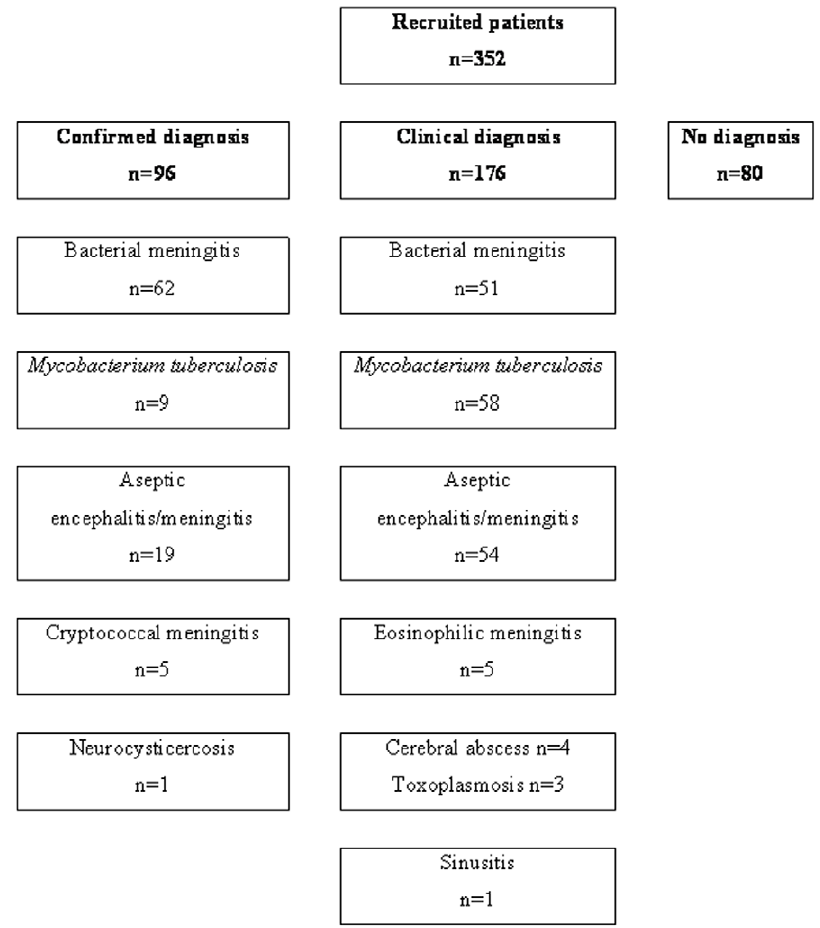
Figure 1. Profile of patient numbers with confirmed and clinically diagnosed meningitis or encephalitis.